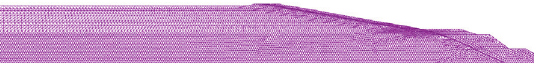
Figure 4: Location of phreatic level at first raising of the dam.